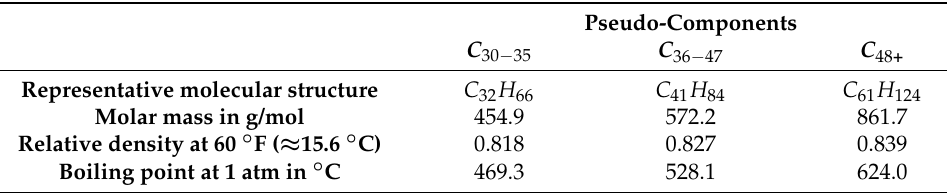
Table 1. Properties of the pseudo-components